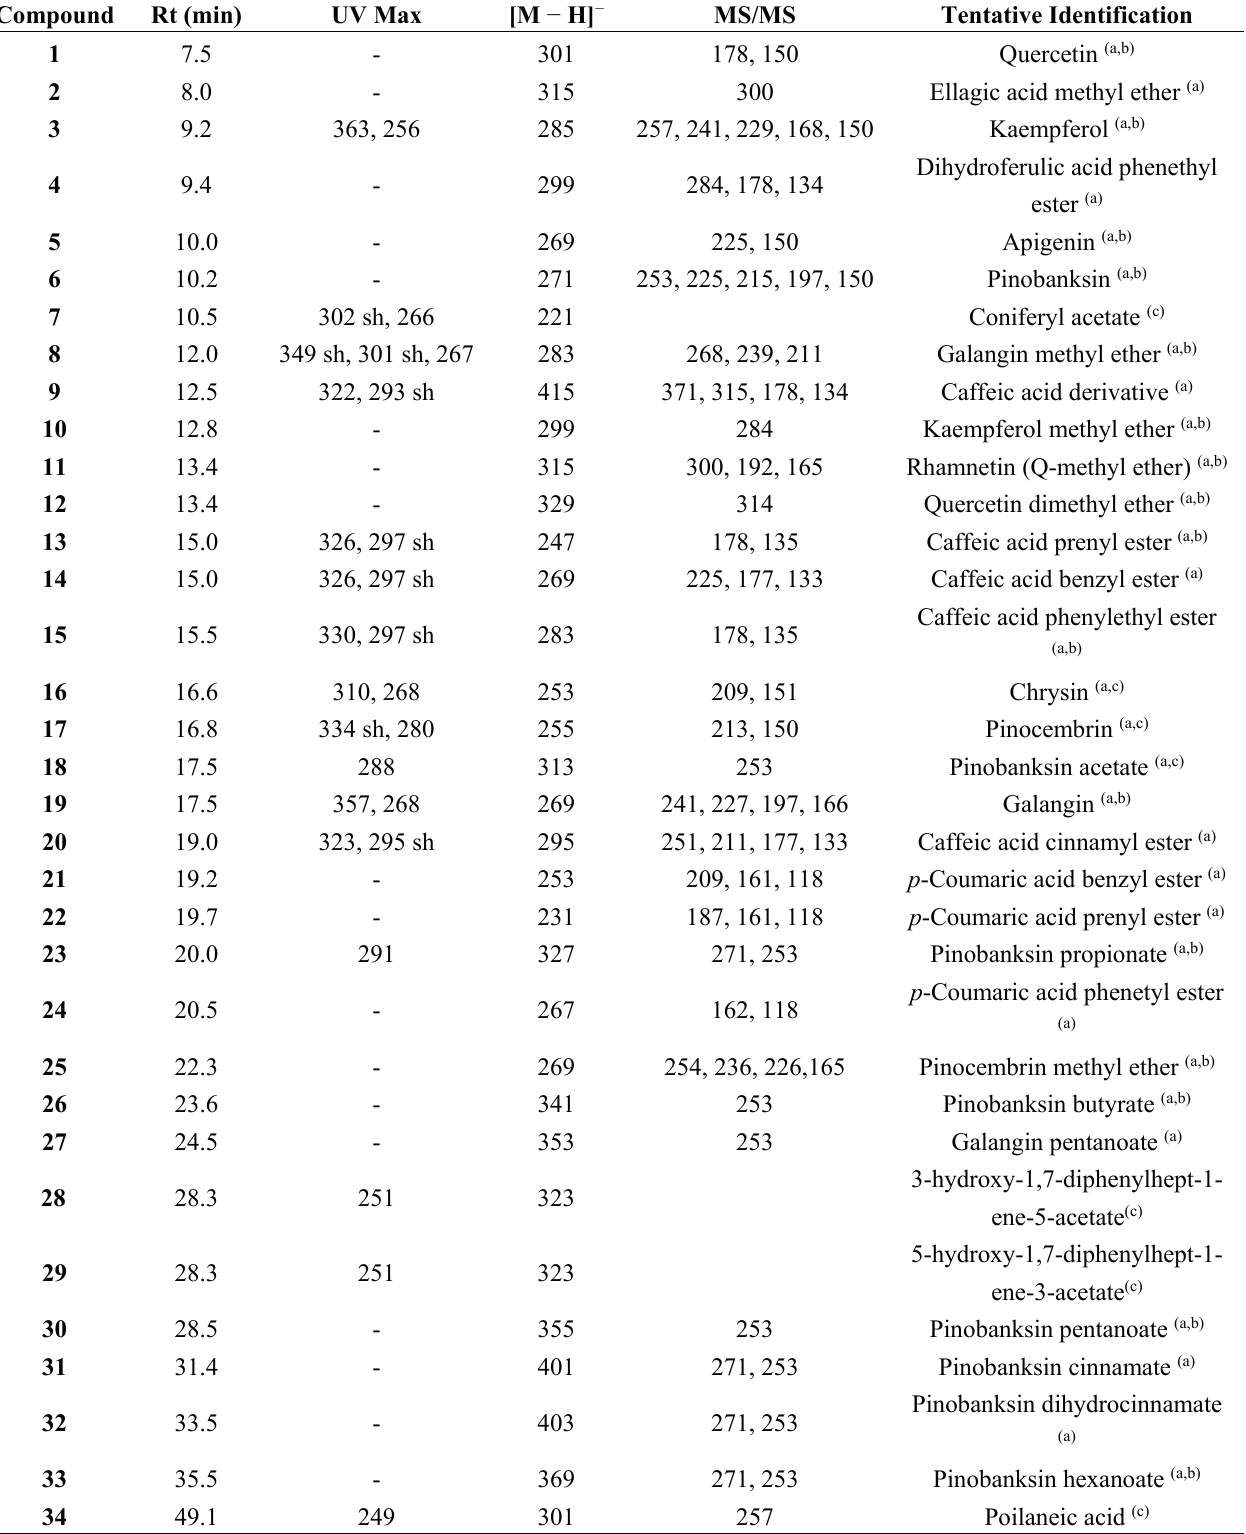
Table 3. Tentative identification of phenolic compounds in propolis from the Región del Maule by